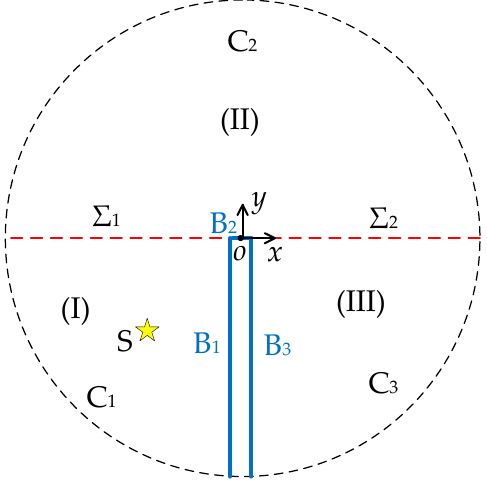
Figure 1. The schematic diagram of the barrier system.